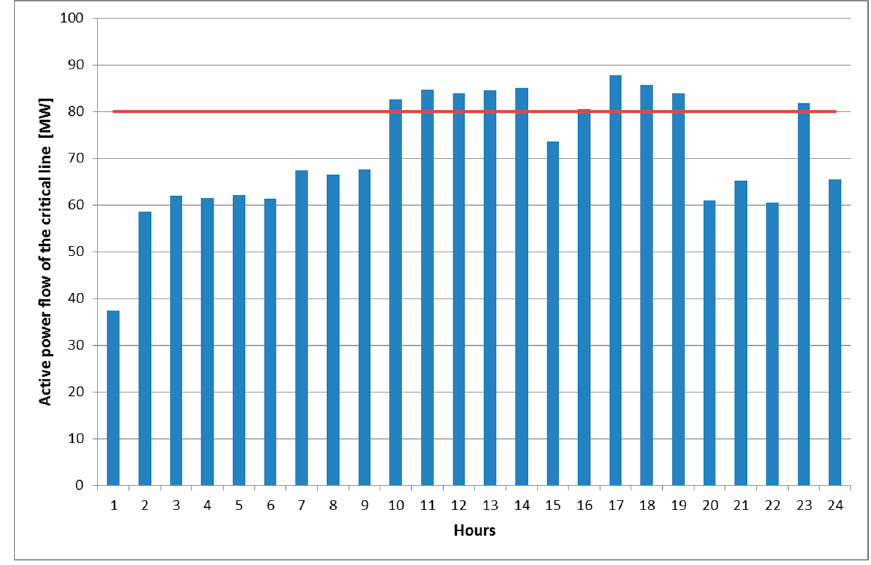
Figure 12. Active power flow of the critical transmission line.